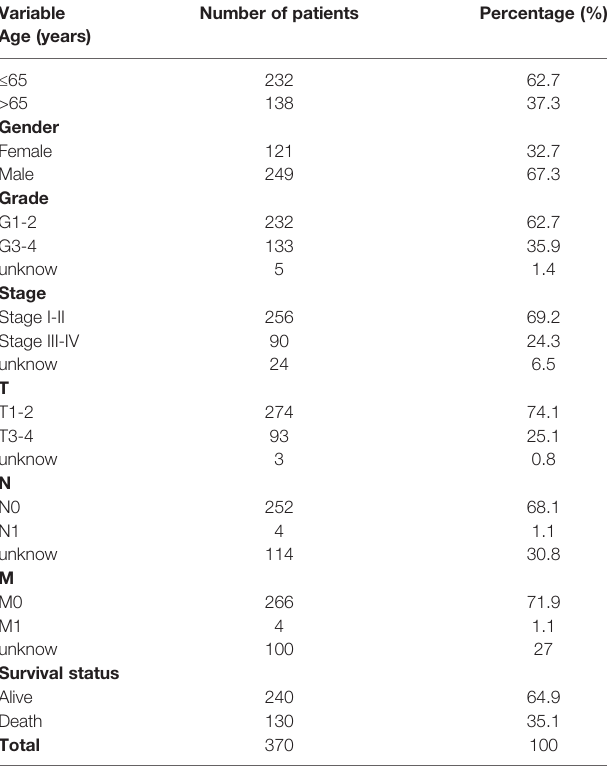
TABLE 1 | Clinical characteristics of patients with LIHC in the study. Variable Number of